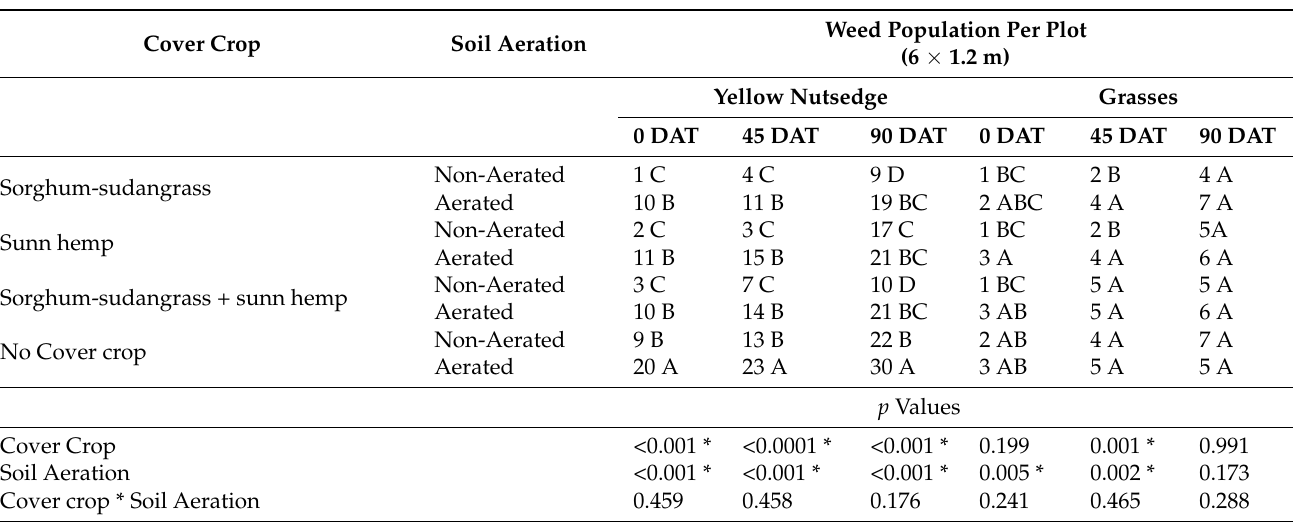
Table 3. Treatment effect on weed control at 0, 45, and 90 days after treatment (DAT) of anaerobic soil disinfestation (ASD) in the 2021 field experiments conducted at the organic research farm, Clemson University Coastal Research and Education Center (CREC), Charleston, SC, USA 1